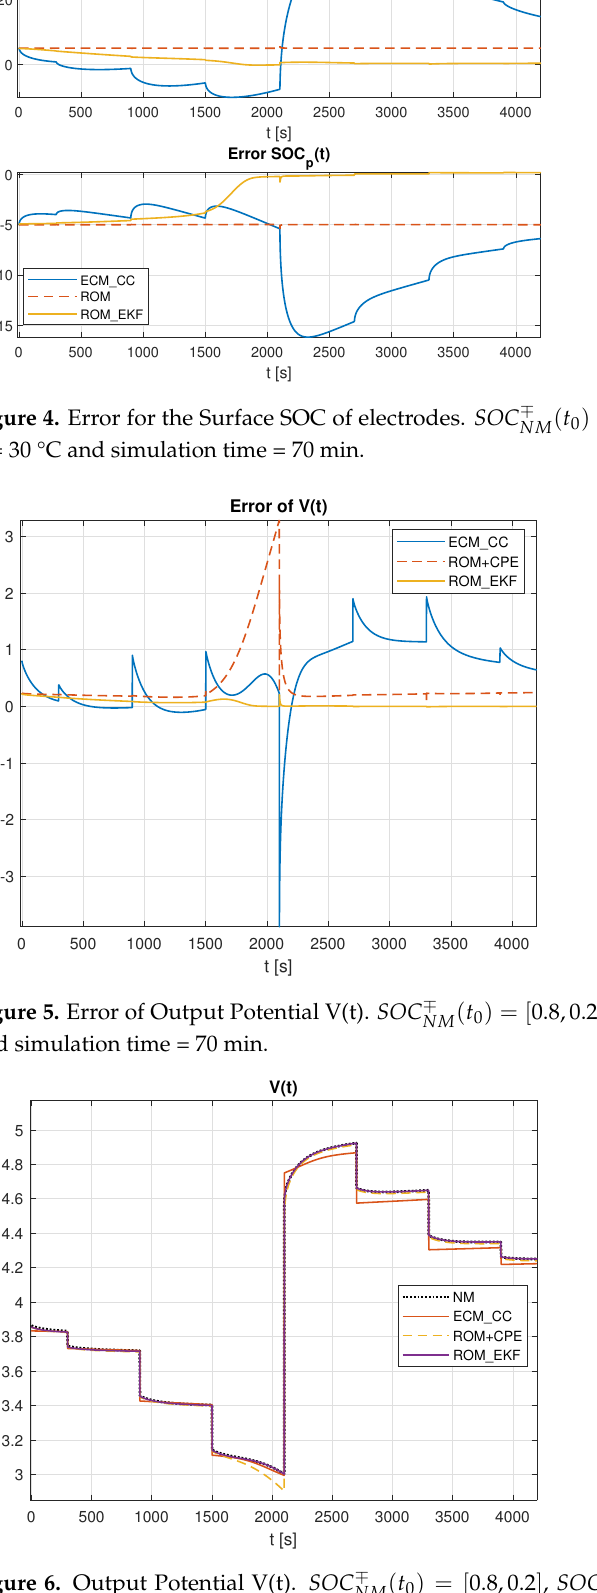
( t ) = [ 0.75,0.25 ] , T = 30 °C and 0 R